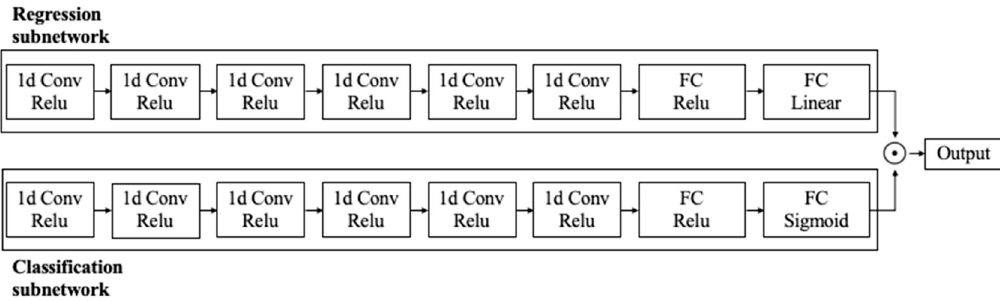
Figure 9. Architecture of subtask gated networks (SGN). ‘FC’ represents a fully connected layer.